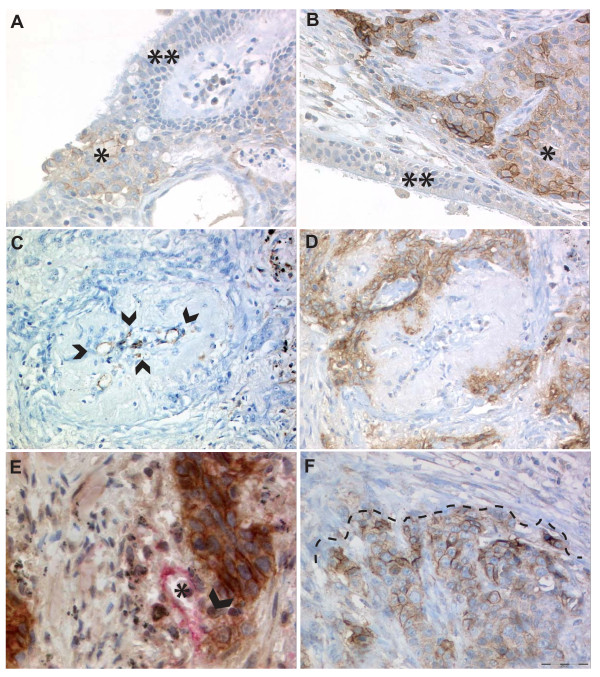
Expression of L1CAM in NSCLC. A/B) SCC with expression of L1CAM (*) whereas the bronchial ciliated and focally metaplastic epithelium is negative (**), magnification 200x. Note on Figure 1B the pronounced expression of L1CAM in some areas of the tumor-stroma interface. C/D) Serial section, C CD31 (endothelial cells marked by arrowheads) and D L1CAM, of a SCC surrounding and partially invading the media of a blood vessel. Note that intratumoral vessels regularly show profound remodeling of the arteriolar wall with disappearance of the elastic layers normally bordering the media myocytes, magnification 200x. E) L1CAM positive tumor cells (brown) destroying the vessel wall lined by CD31 positive (red) endothelial cells. F) Accentuated L1CAM expression at the tumor-stroma interface (dashed line) and weaker (heterogeneous) L1CAM expression in the lower part of the picture representing a central part of the tumor. Hematoxylin counterstain was used for all slides.